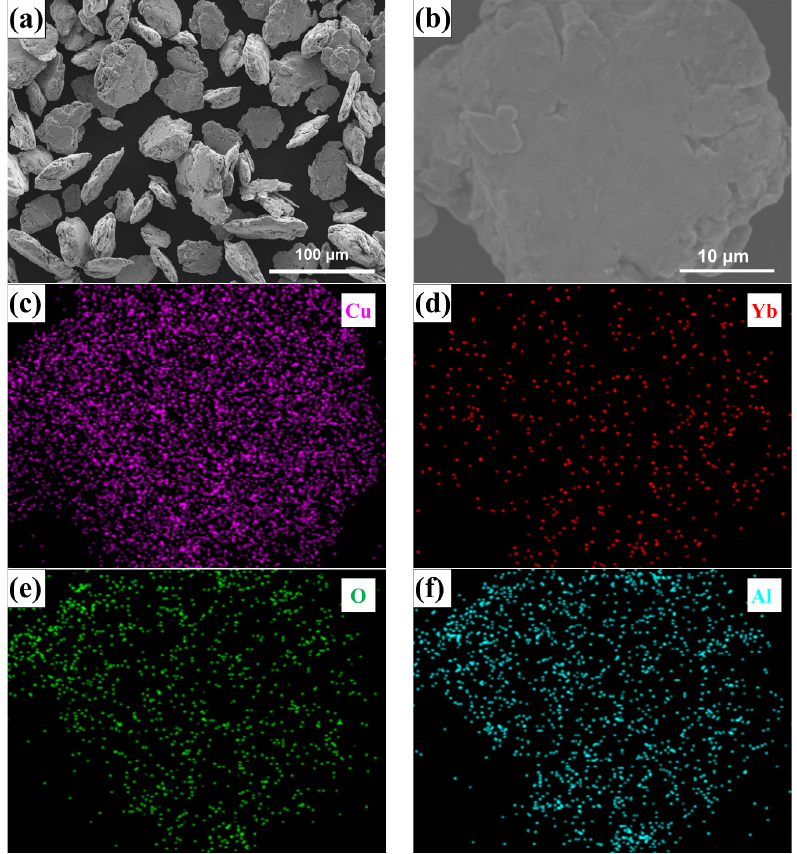
Figure 1. ( a ) Typical SEM morphology of the MA powders; ( b ) SEM image of one disc powder